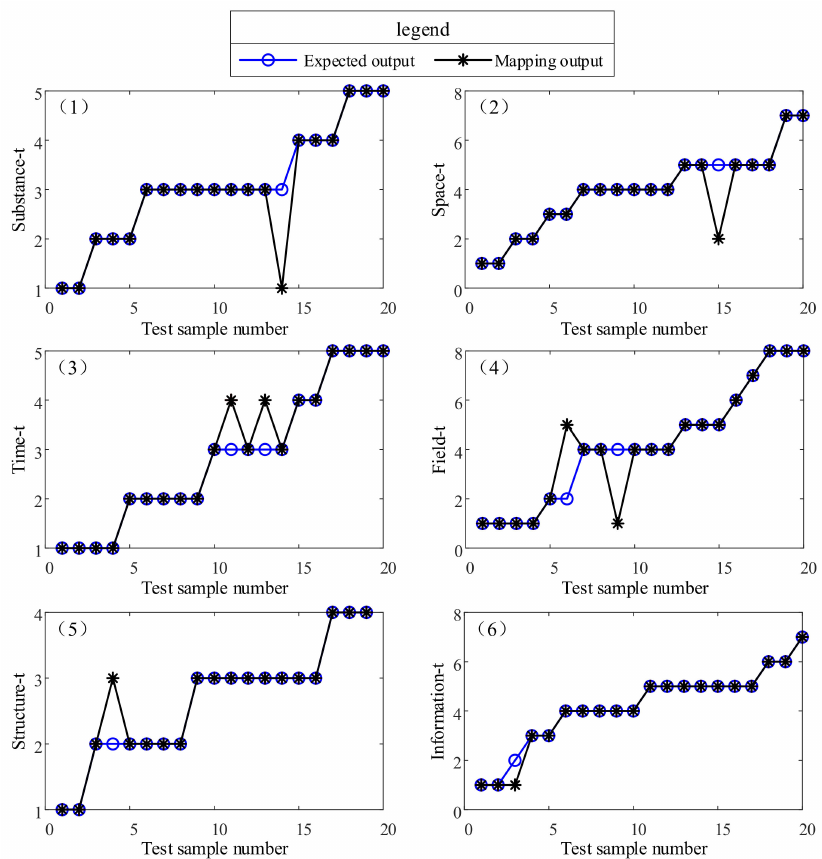
Figure A2. Training results of sequence ( t ) mapping model between physical parameters and various engineering